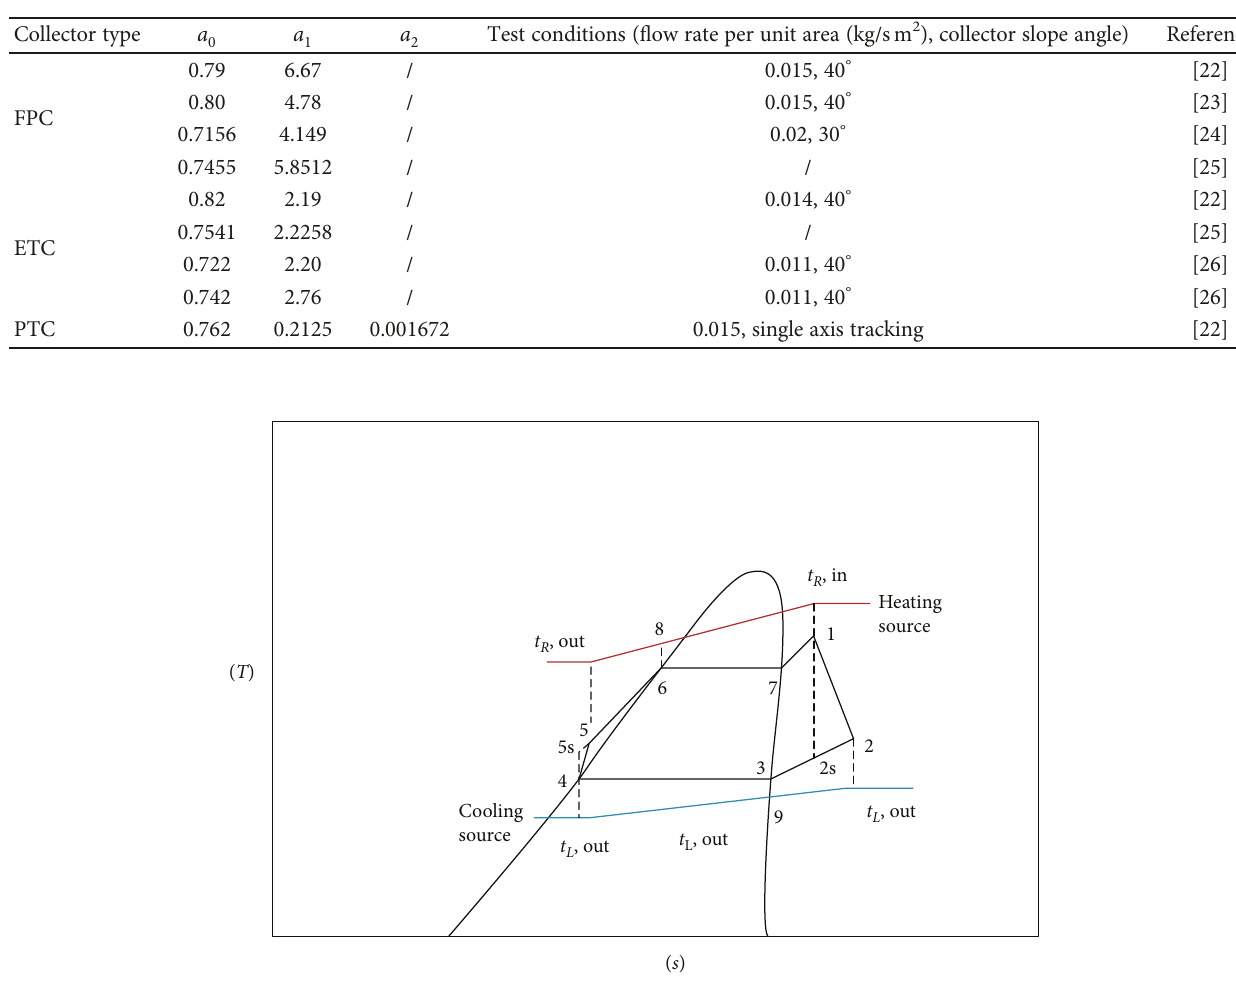
Table 1: Coe ffi cients a